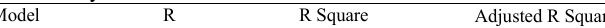
Model Summary b Model R R Square Adjusted R Square Std. Error of the Estimate Durbin-Watson 1 .658 a .567 2.129 a. Predictors (Constant): TP, WCs, S, W, RAR b. Dependent Variable: JSAA